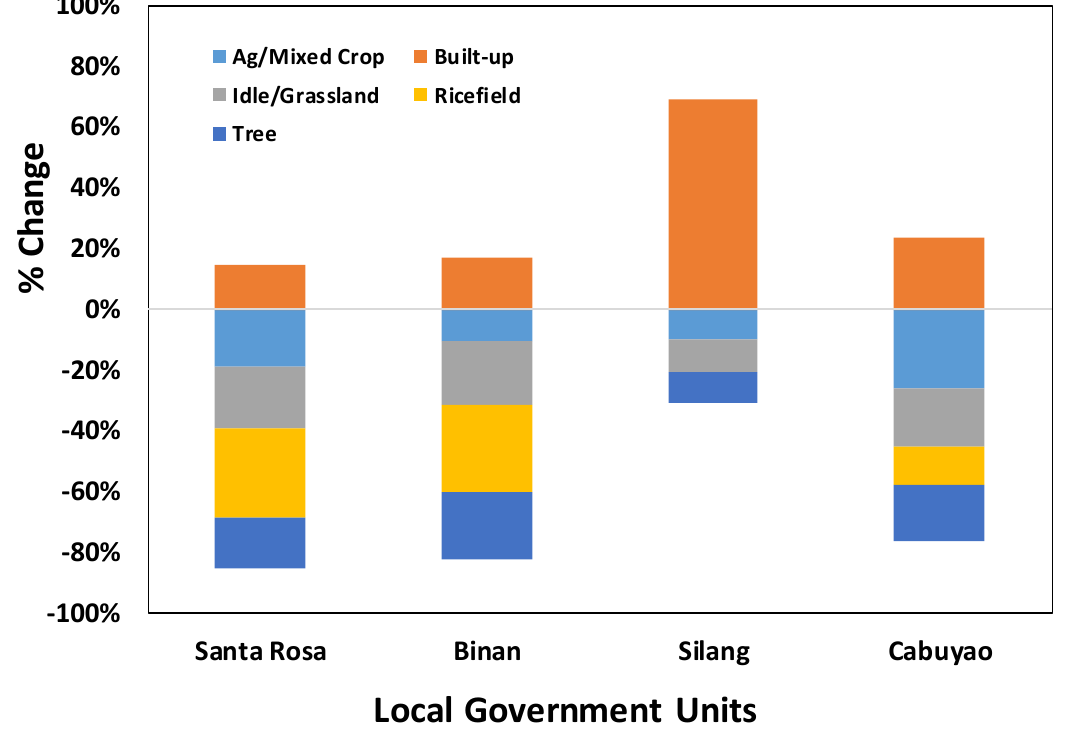
Figure 6. Percentage of land use land cover change among four different local government units (LGUs) coming within Santa Rosa sub-watershed.